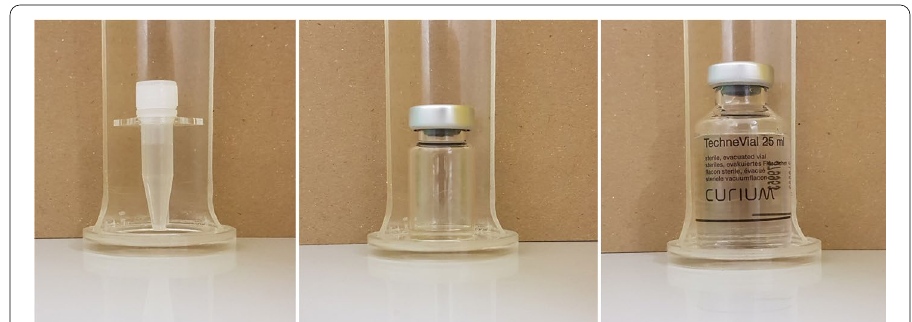
Fig. 5 Eppendorf tube (left), sterile glass vial (middle) and GMP vial (right), in their respective holders before insertion inside the well of the ionization